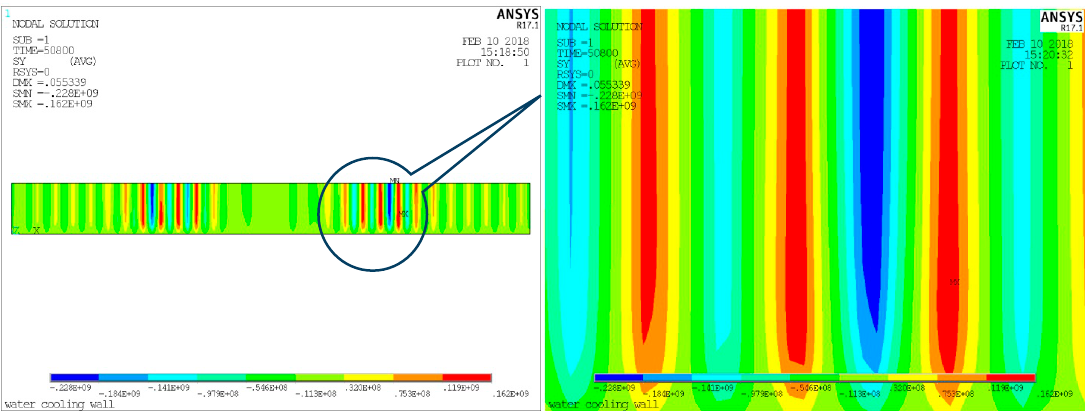
Figure 16. Vertical water wall expansions at the front wall. As shown in Figure 17, when the boiler operates at a load of 180 MW, the maximum shear stress appears and reaches 228 MPa according to the third strength theory. The shear stress array for this point is simulated in Figure 17, where the power output changes over time. The shear stress impacts the cyclic stress of the front wall considerably. The thermal stress and cyclic stress of the most dangerous point at the front wall could be estimated, and the influence of the flexible operation on the lifetime consumption of the water-cooled wall can be further evaluated.